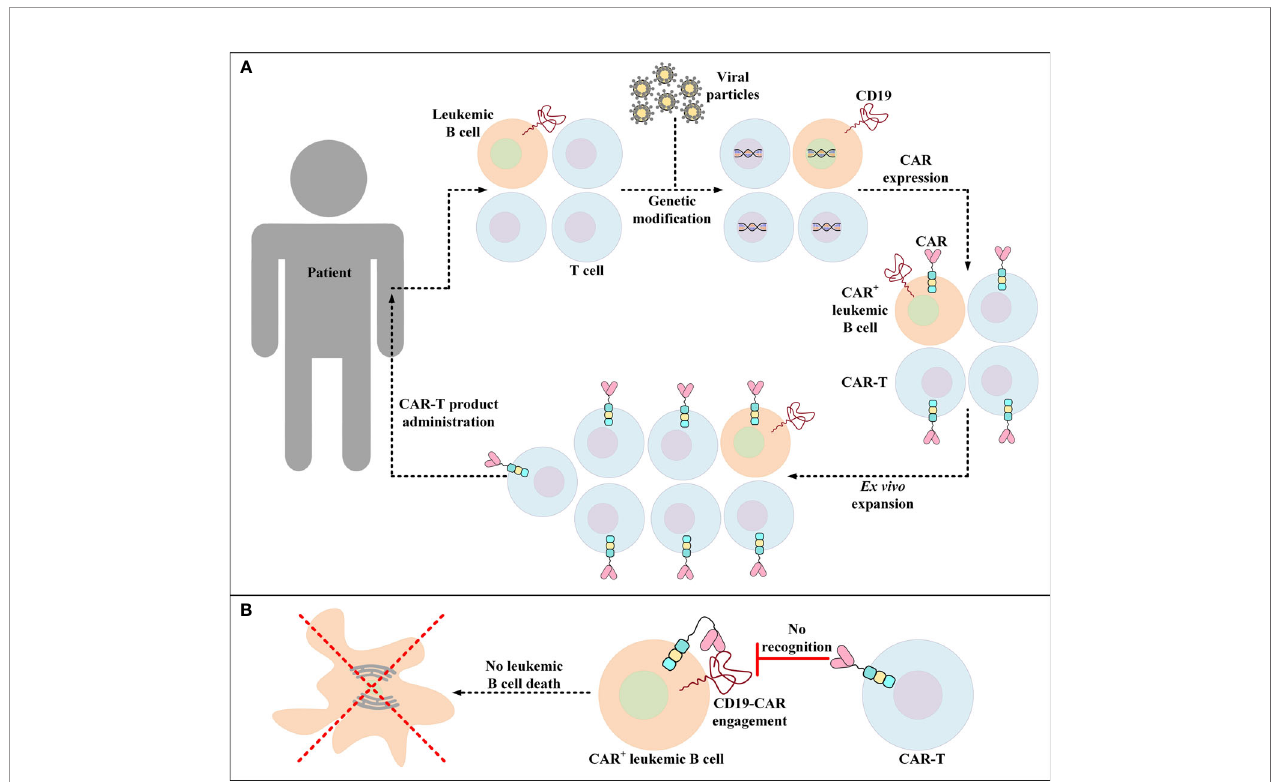
FIGURE 3 | Accidental transduction of leukemic B cells and the emergence of resistance to CAR-T therapy. (A) Accidental transduction of leukemic B cells during the process of CAR-T preparation. An error in the isolation of T cells leads to the contamination of the cell pool with leukemic B cells. Moreover, in the process of genetic modi fi cation, leukemic B cells are transduced along with the isolated T cells for the expression of certain CD19-speci fi c CARs. (B) Resistance of CAR + leukemic cells to a particular CD19-redirected CAR-T product. Following the administration of the developed product into patients, CAR + leukemic cells become resistant to that particular CD19-redirected CAR-T product due to the engagement of their CD19 with their self-expressed CARs (a process known as epitope masking ). This incident might also occur in the case of CAR-T products that target different target antigens than